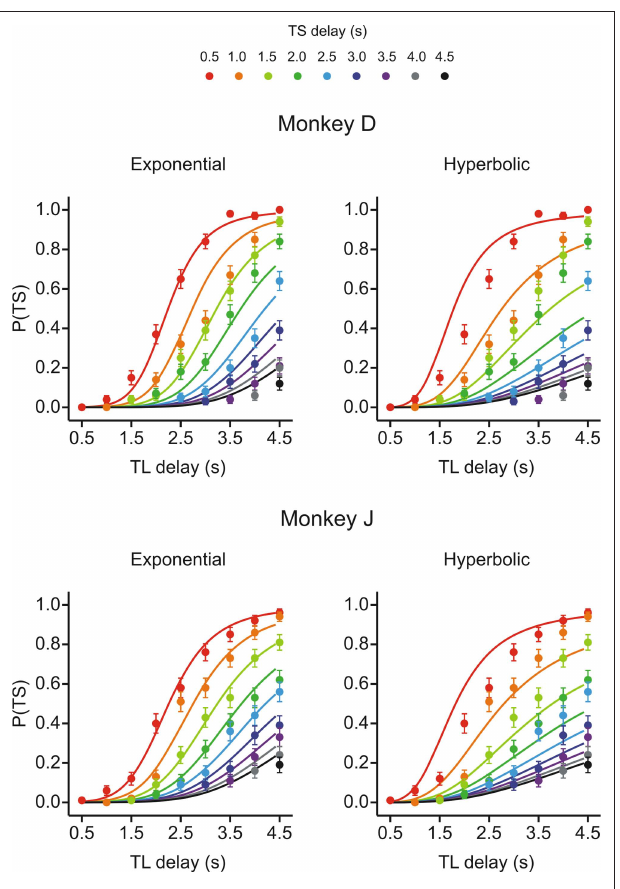
FIGURE 2 | Choice behaviors in Experiment I-A. Plots show the probability that the animal would choose the small-reward target as a function of the delays for the large-reward (TL) and small-reward (TS) targets, which are indicated in the abscissa and by different colored symbols, respectively. Lines indicate the predictions from the exponential (left) or hyperbolic (right) discount functions. Error bars,